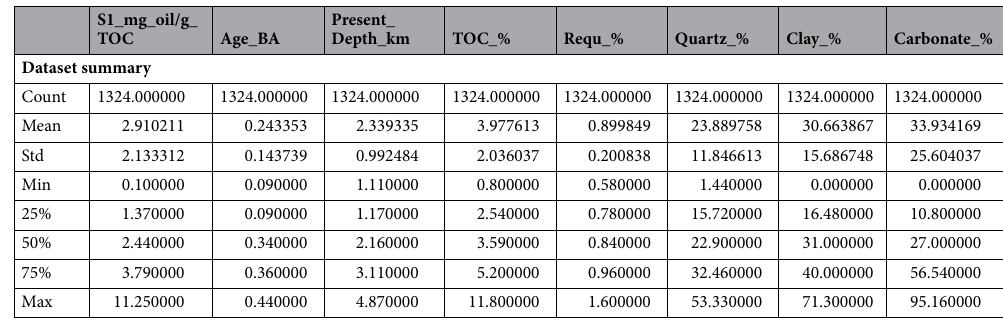
Table 1. Training and validation dataset summary.